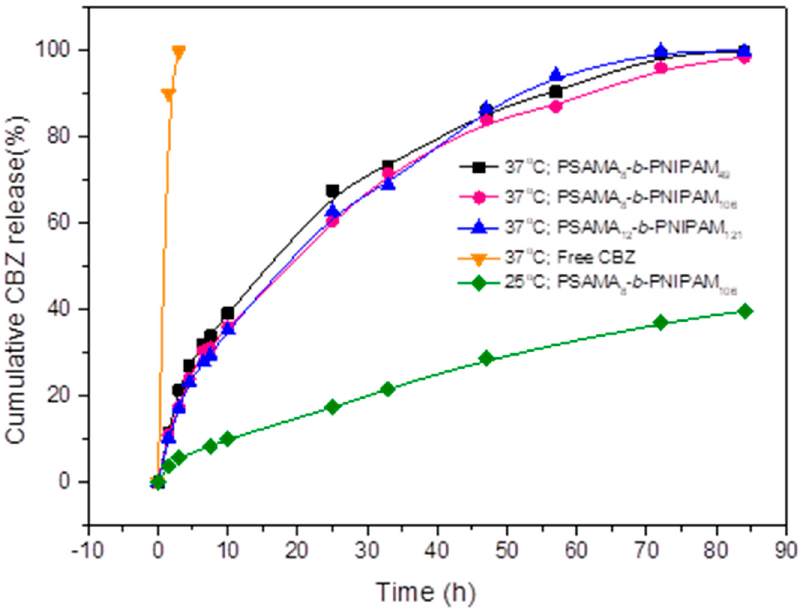
Figure 7. Release profiles in vitro of free CBZ and CBZ drug-loaded micelles in PBS (pH 7.4) at 37 and 25 °C.